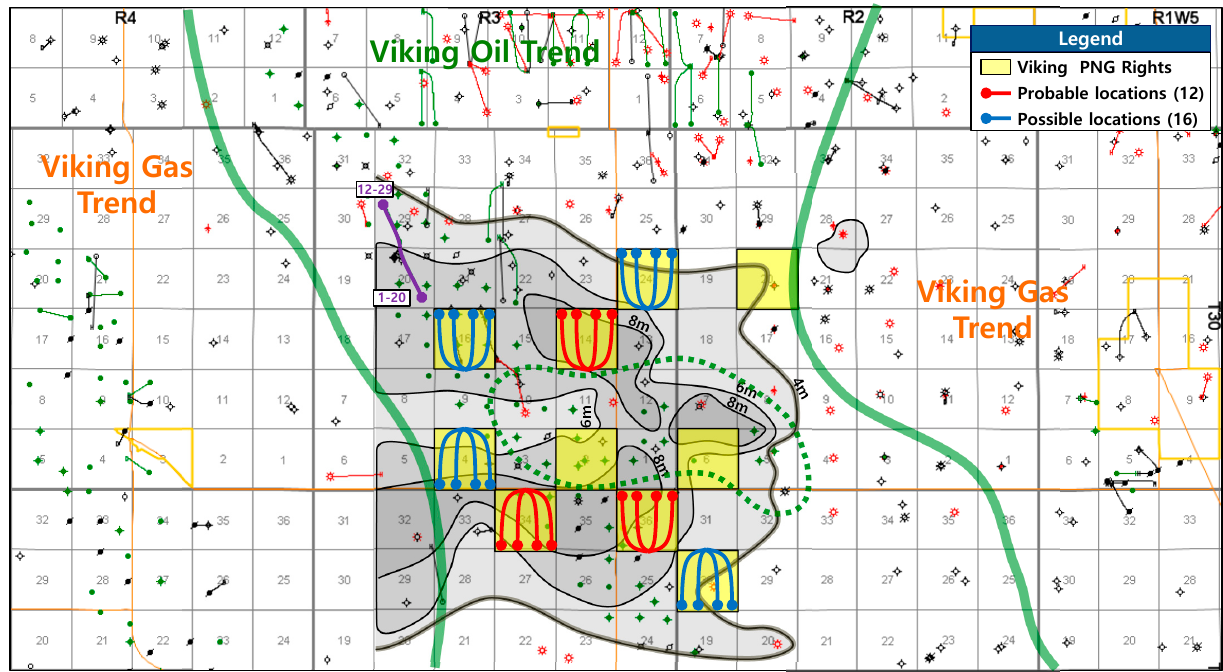
Figure 9. Viking development plan by net pay mapping with economic evaluation.